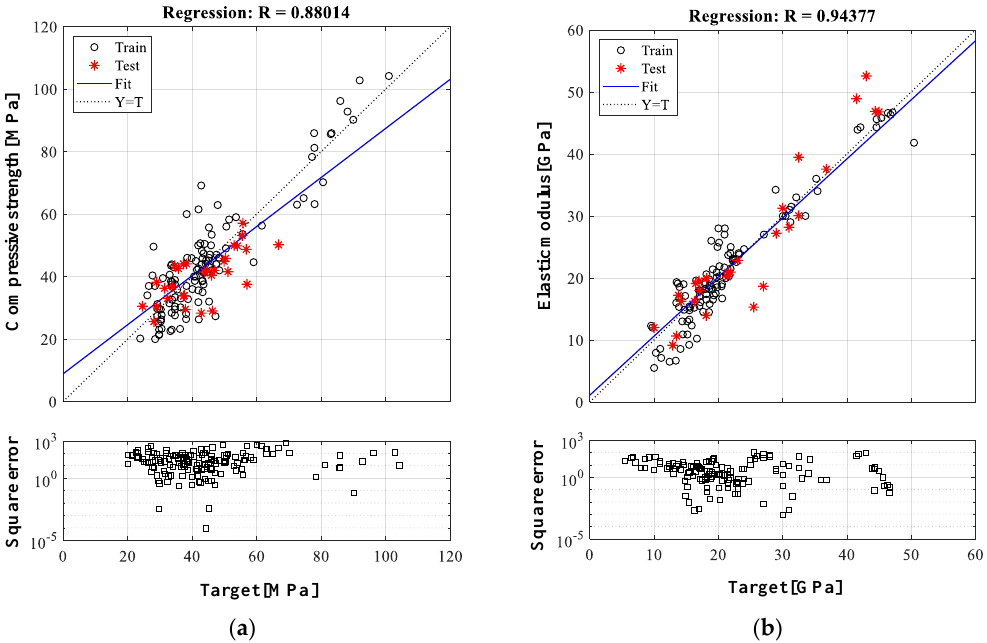
Figure 6. Prediction results from multiple nonlinear regression (MNLR)-based analysis: ( a ) compressive strength and ( b ) elastic modulus.